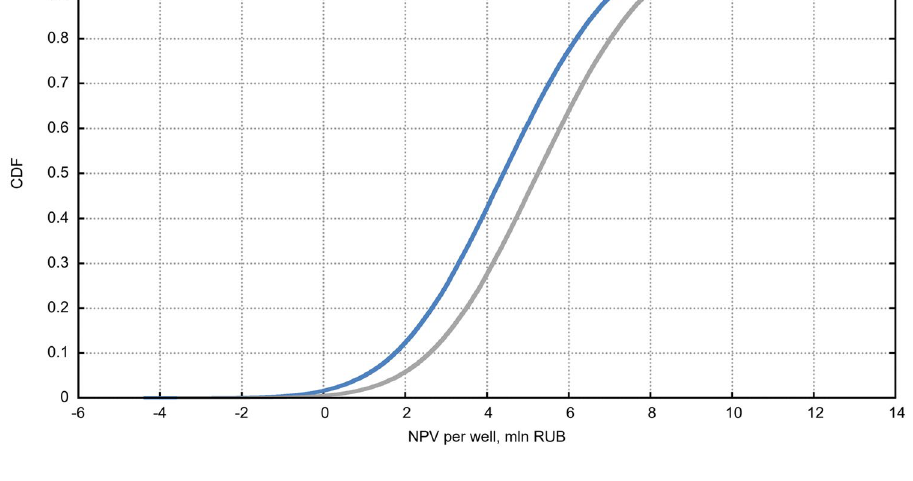
Fig. 18 Cumulative distribution functions (CDF) for the NPV of the drilling projects according to scenario